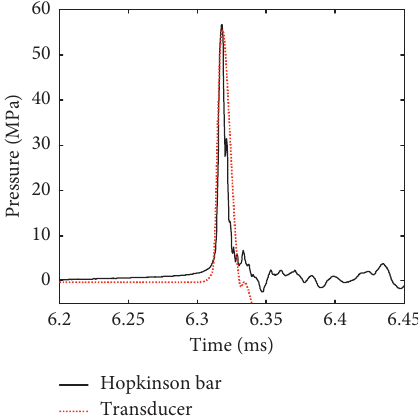
Figure 11: c � 0.33; Hopkinson bar measured data and transducer measured data